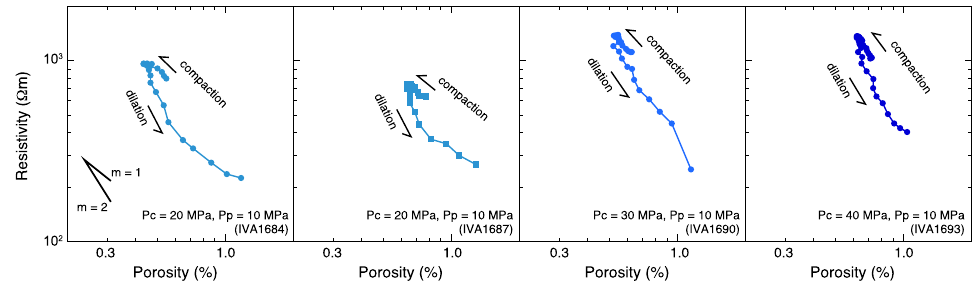
Fig. 5 Relationship between the electrical resistivity and porosity during the deformation of each sample, with the different trends between compaction and dilation caused by crack closure and development shown